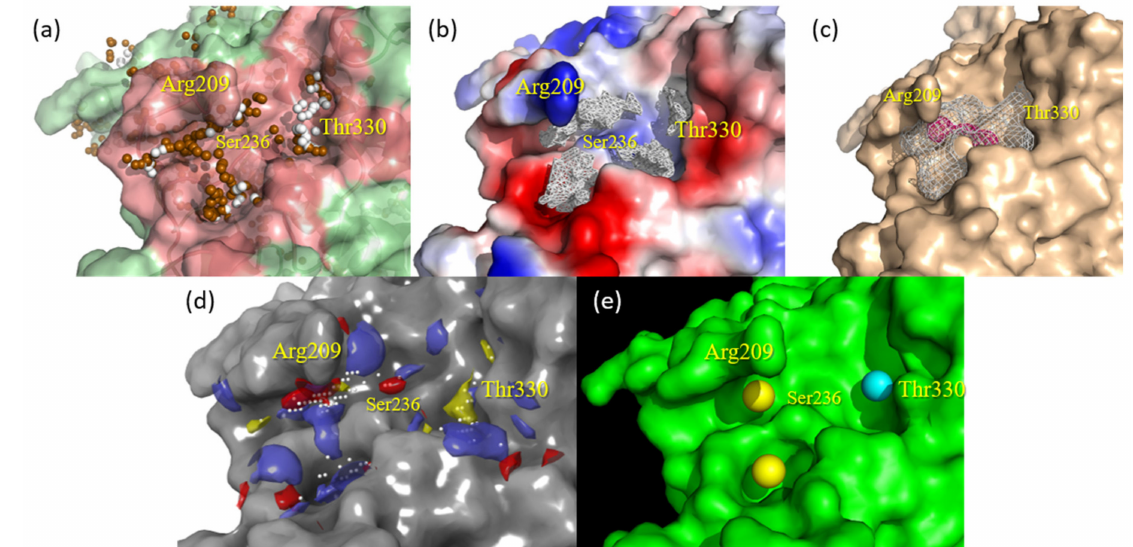
Figure 3. ( a ) Cavity detected using fpocket, represented here by brown (polar groups) and white (apolar groups) spheres. ( b ) White mesh shape of cavity predicted by Superstar. ( c ) Best scoring pocket by metaPocket, represented by white mesh (cluster of sites indicated in consensus by three methodologies) and pink spheres (mass center of the global site). ( d ) Sitemap cavity occupied by white spheres. ( e ) Cavity with the highest potential of representing an allosteric site, according to PARS. All images were produced using Pymol [22], showing Pocket 7 of GSK-3 β